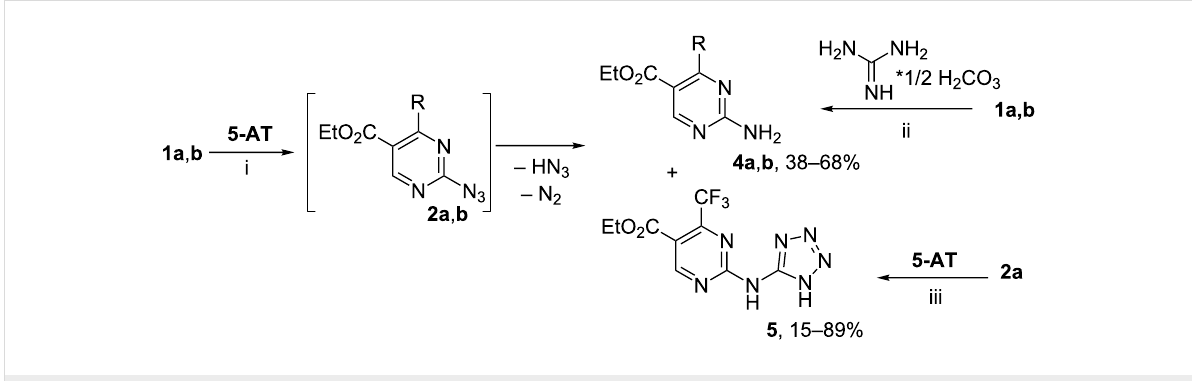
Scheme 2: Synthesis of pyrimidines 4a , b and 5 . R= CF 3 ( a ), (CF 2 ) 2 H ( b ). Conditions: i: 1,4-dioxane, NaOAc, Δ , 16–18 h; ii DMF, NaOAc, 80 °C, 24–26 h; iii: 1,4-dioxane, Et 3 N, Δ , 40